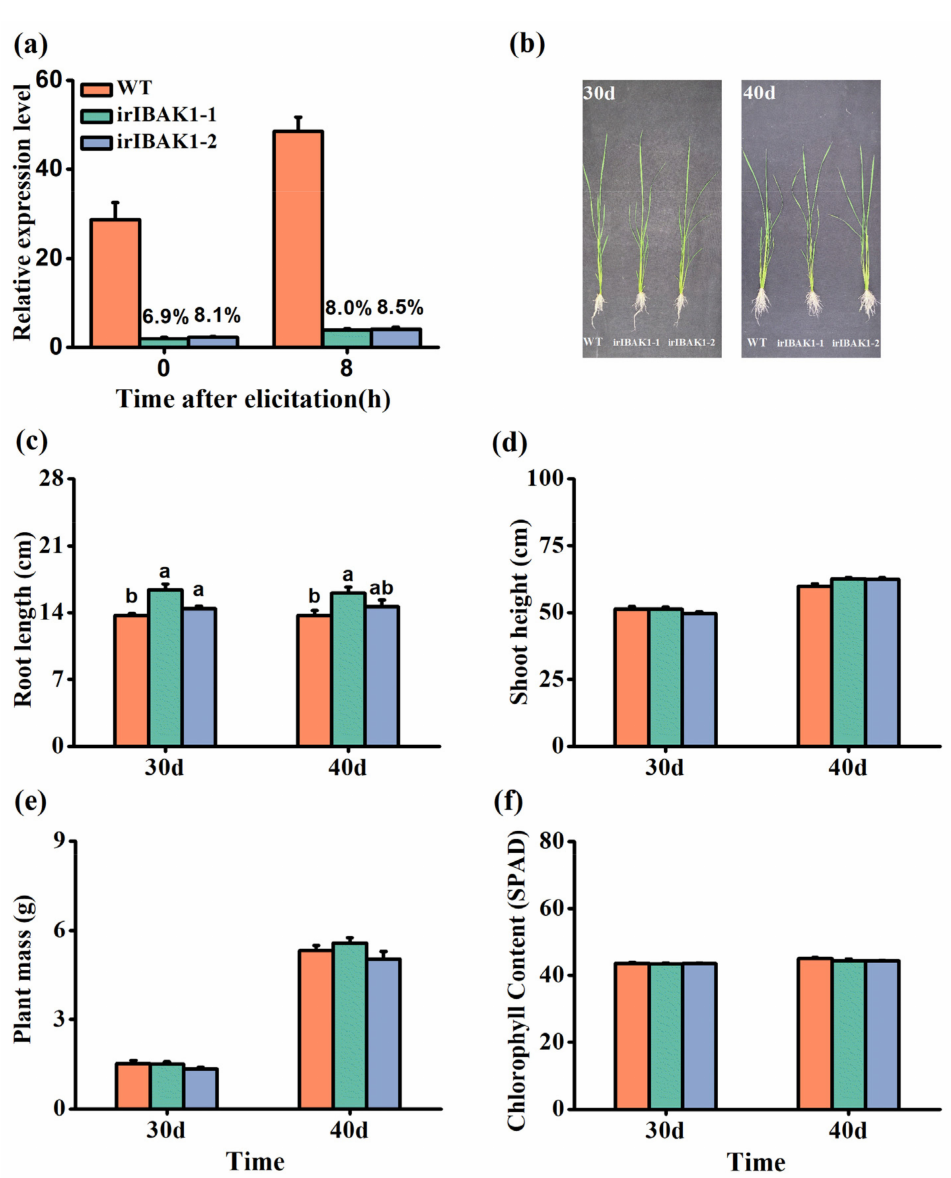
Figure 3. Transgenic lines silencing OsI-BAK1 and their growth phenotypes. ( a ) Mean expression levels (+SE, n = 5) of OsI-BAK1 in wild-type (WT) and ir- ibak1 plants at 0 and 8 h after BPH infestation. Percentages indicate the percentage of the expression levels of OsI-BAK1 in ir- ibak1 plants compared to the expression levels of OsI-BAK1 in WT plants. ( b ) The growth phenotype of 30- and 40-day-old WT and ir- ibak1 plants in the greenhouse. ( c – f ) Mean root length ( c ), shoot height ( d ), plant mass ( e ) and chlorophyll content ( f ) (+SE, n = 10) of WT and ir- ibak1 plants at 30 or 40 days old in the greenhouse. Different letters represent significant differences among the lines ( p < 0.05, Tukey’s HSD post-hoc